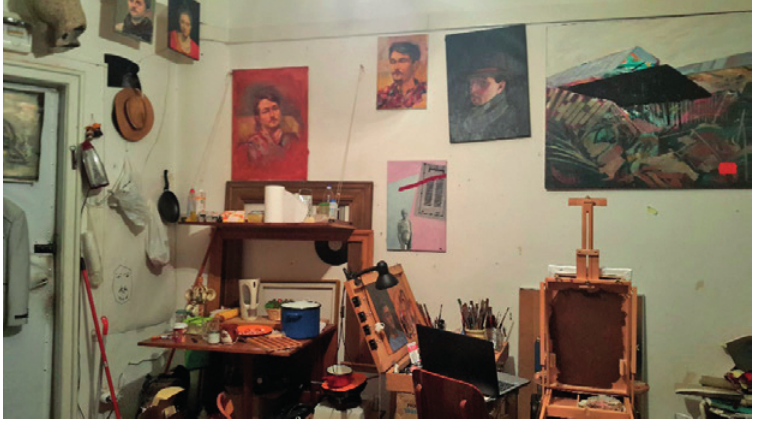
Figure 3. Artist studio (source: photo was taken by author during the field work)